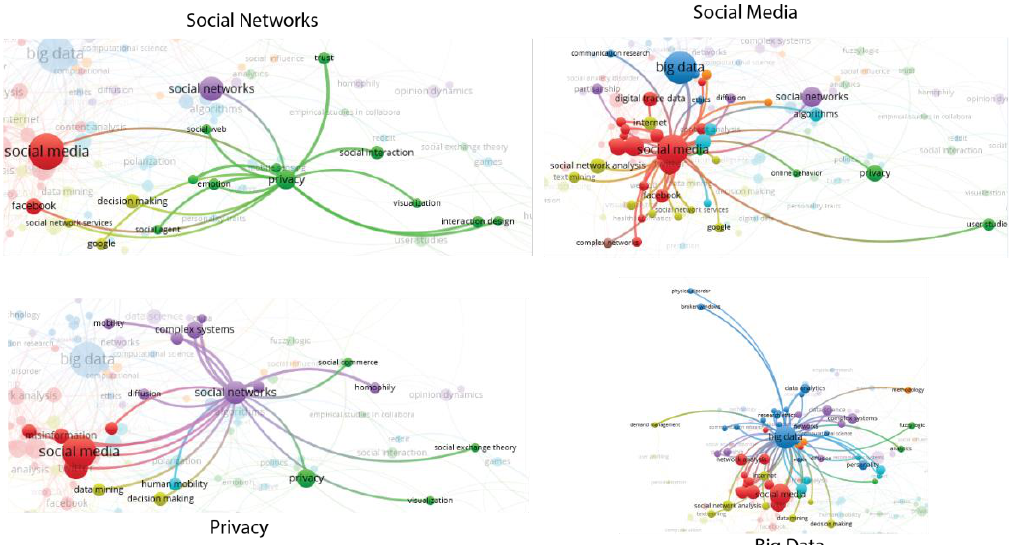
Figure 10. Focus view of Author Keywords of CSS: Big Data, Social Media, Social Networks and Privacy, based on WoS, CSS dataset.